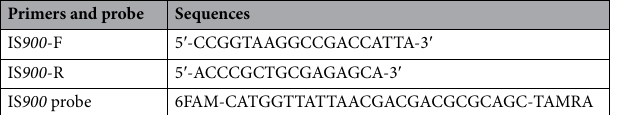
Table 6. Primers, probe, and their sequences used in qPCR